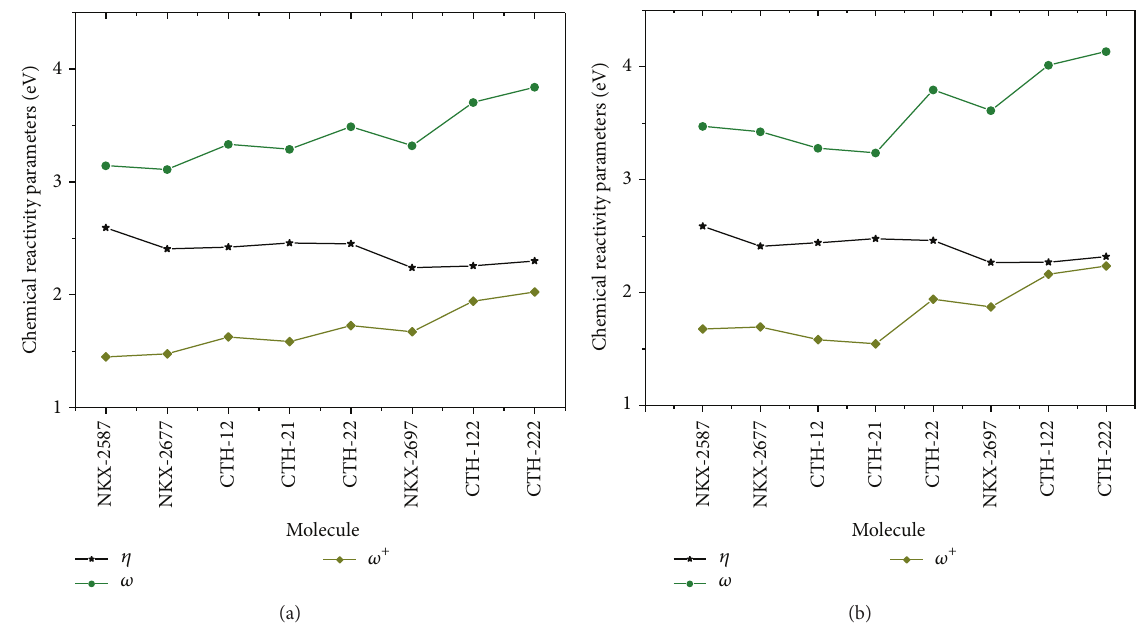
Figure 5: Chemical hardness, electrophilicity index, and electroaccepting power of coumarin dyes using the M06 functional with the basis sets: (a) 6-31G(d) and (b)